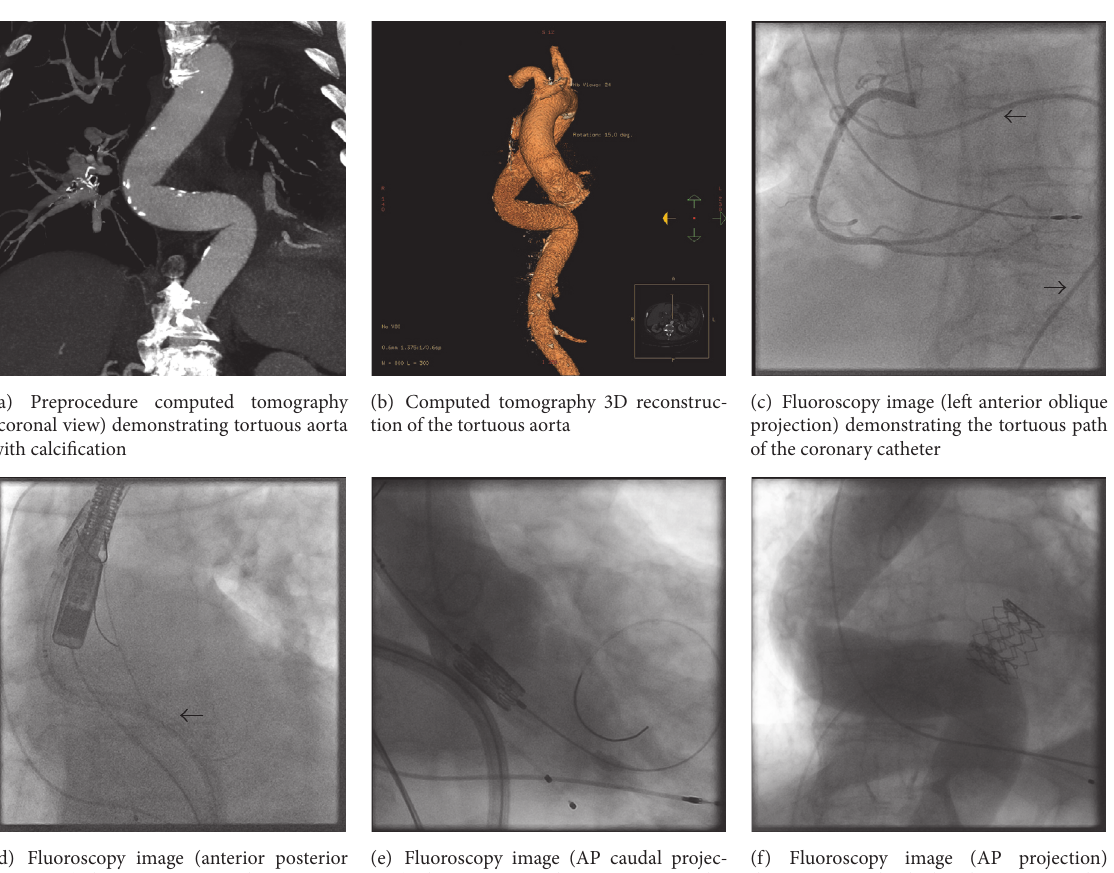
Figure 1: Composite image of a tortuous S-shaped